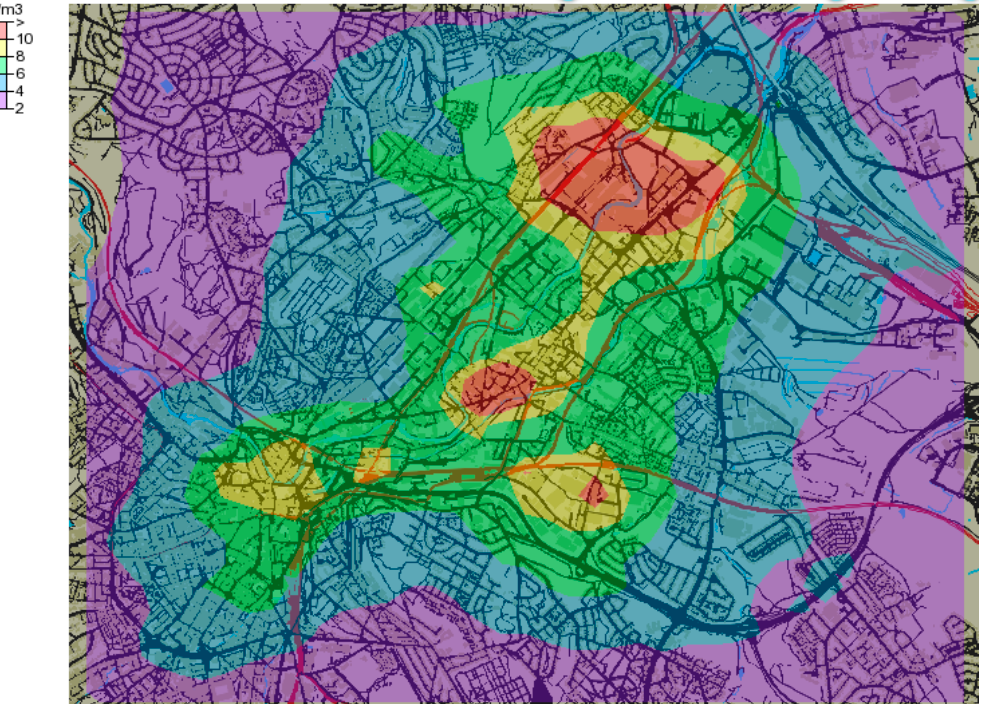
Figure 7. Estimated annual mean PM 10 concentrations (µg/m 3 ) using all emission sources in Sheffield City Centre for the year 2017.